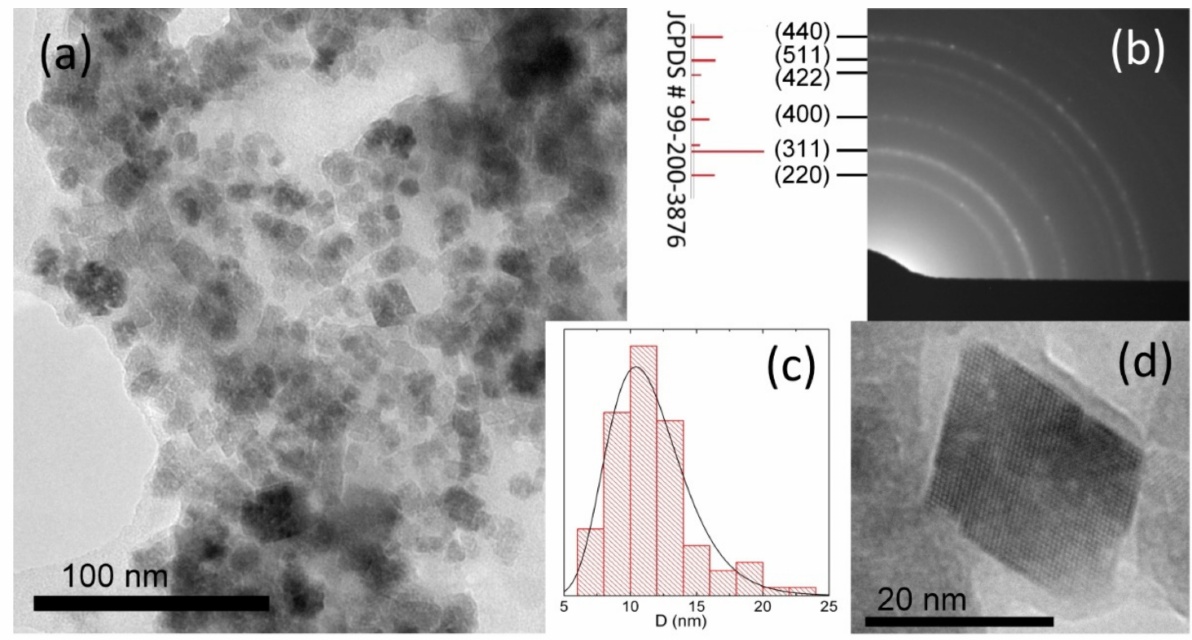
Figure 1. HRTEM images at ( a ) the × 100 k and ( d ) × 400 k magnifications, ( b ) microdiffraction pattern, and ( c ) size distribution of the synthesized iron oxide